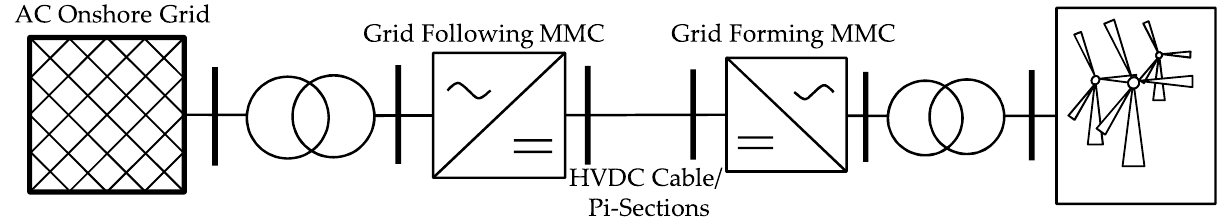
Figure 20. HVDC system connecting offshore windfarm to AC system.